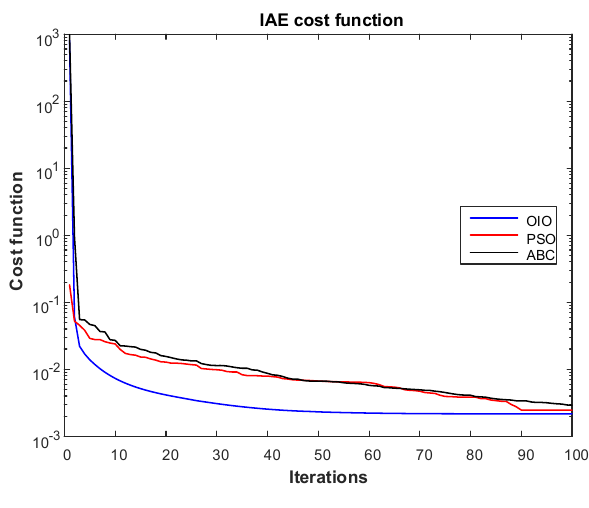
Figure 16. Iteration history for IAE.